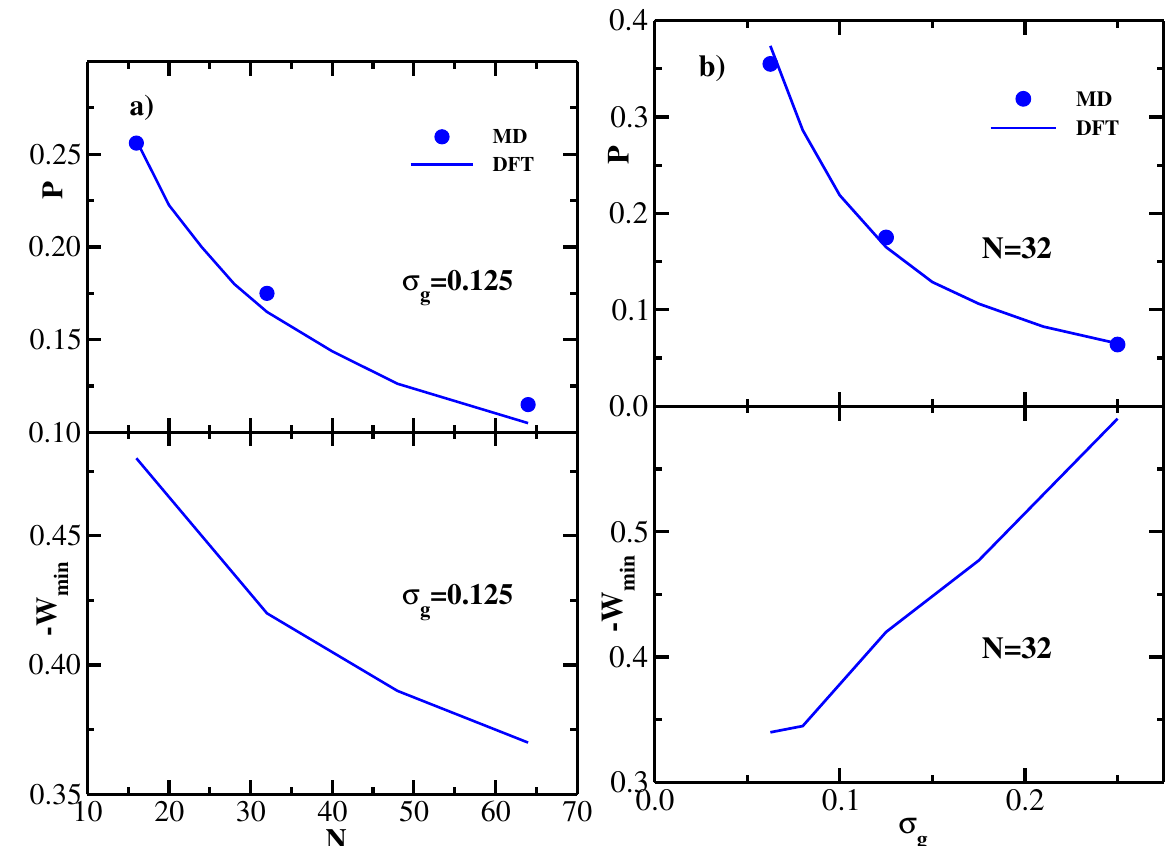
Figure 2. ( a ) Upper panel: overlap P defined via Equation (20) as a function of the grafted chain length N for two monodisperse flexible brushes at equilibrium separation; grafting density is σ g = 0.125. Solid line shows the present DFT results, and symbols are from MD simulations [26]. Lower panel: DFT results for the (negative) minimum of the PMF between two monodisperse flexible brushes as a function of the grafted chain length N ; grafting density is σ g = 0.125. ( b ) Upper panel: overlap P defined via Equation (20) as a function of the grafting density σ g for two monodisperse flexible brushes at equilibrium separation; grafted chain length is N = 32. Solid line shows the present DFT results, and symbols are from MD simulations [26]. Lower panel: DFT results for the (negative) minimum of the PMF between the two monodisperse flexible brushes as a function of the grafting density σ g ; grafted chain length is N =